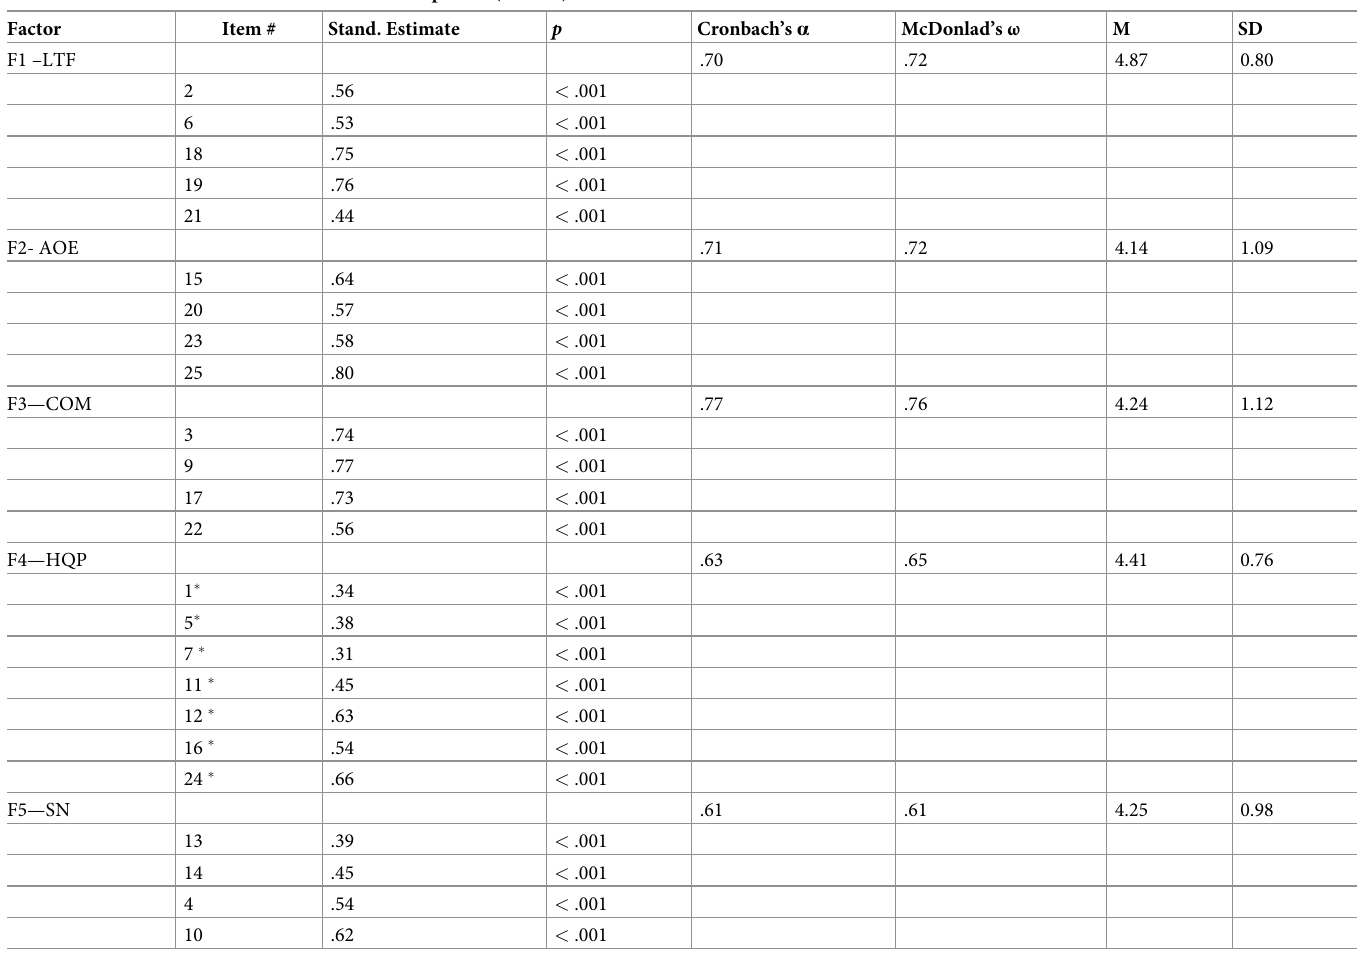
Table 2. Characteristics of the five-factor model improved (n =